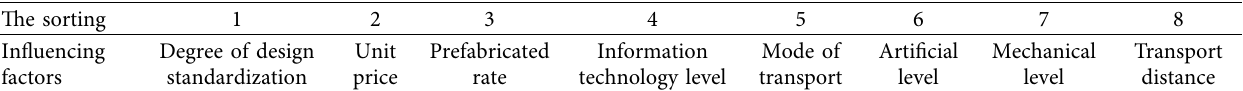
Table 6: Results of influencing